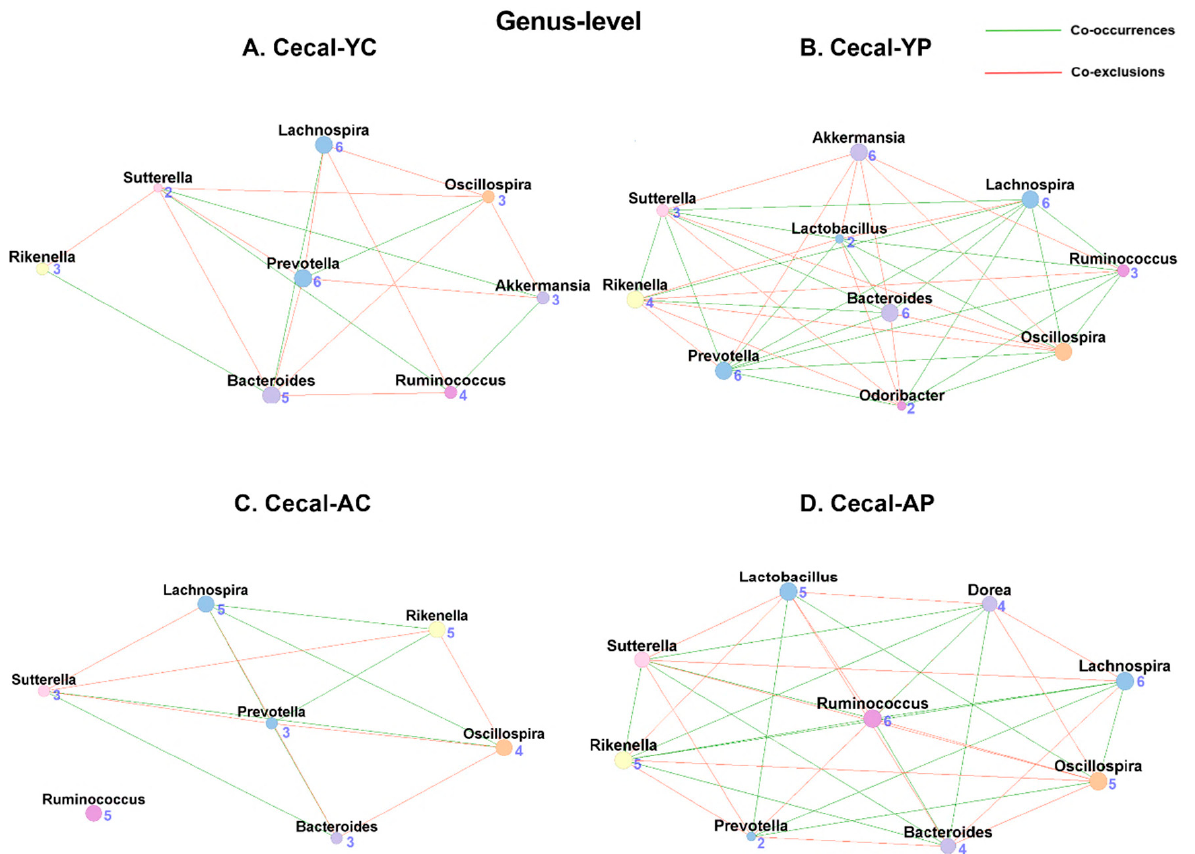
Figure 10. Microbial co-occurrence in the cecal microbiome in young and aging mice at the genus level. Co-occurrence networks were constructed based on relative abundance profiles of fecal microbes using Kendall’s Tau correlation analysis in young control ( A ), young probiotic ( B ), aging control ( C ), and aging probiotic ( D ) groups. Each node represents a genus. Each edge indicates the sign of the association (green = positive (co-occurrences), red = negative (co-exclusions)). The thickness of the nodes represents the level of association between taxa.